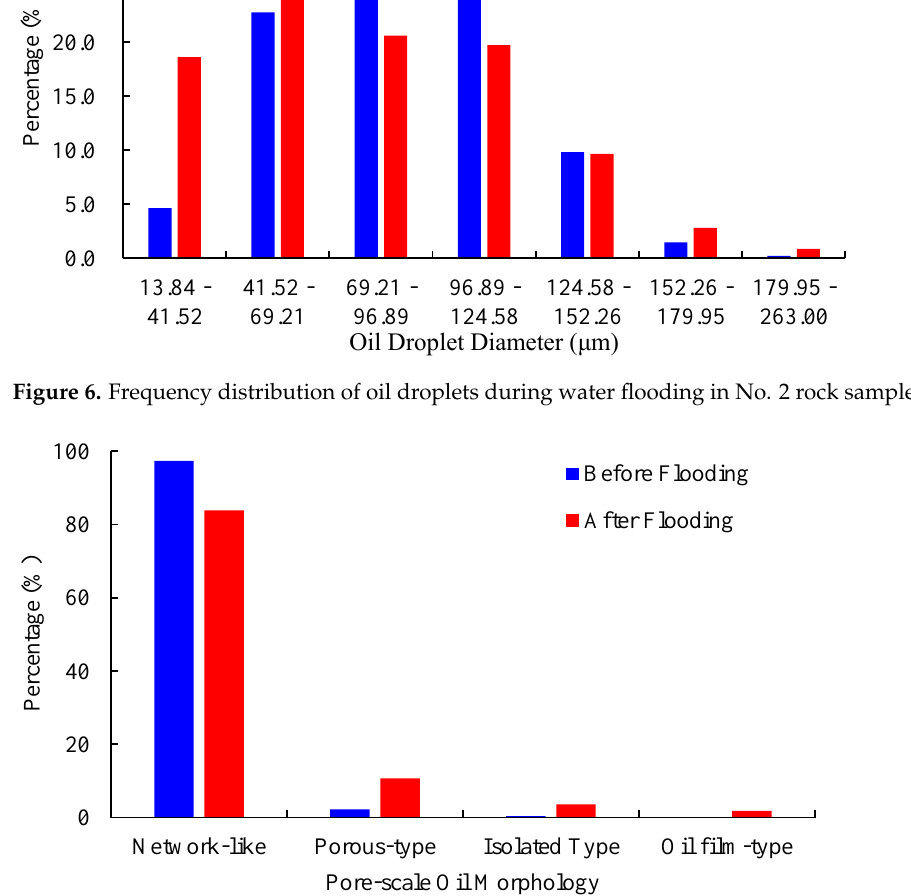
Figure 7. Pore-scale morphology of oil droplets during water flooding in No. 2 rock sample. Table 2. Geometrical analysis of residual oil droplets in No. 2 rock sample. CT Imaging Phase